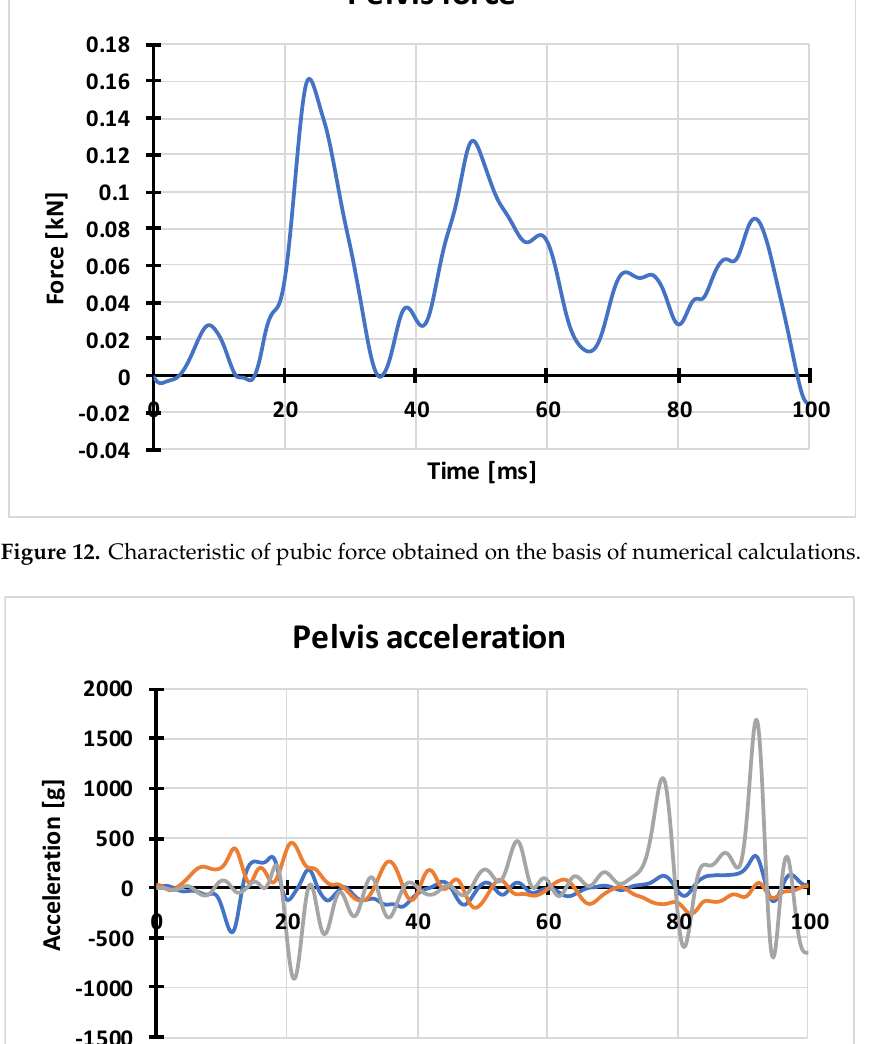
Figure 11. Characteristic of axial force in the dummy's abdomen obtained on the basis of numerical calculations.